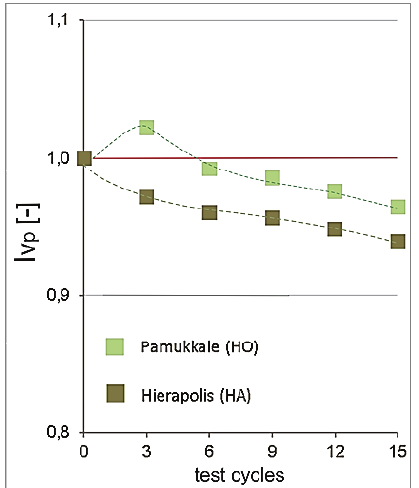
Fig. 3. Strength reduction index I Rc after the impact of frost